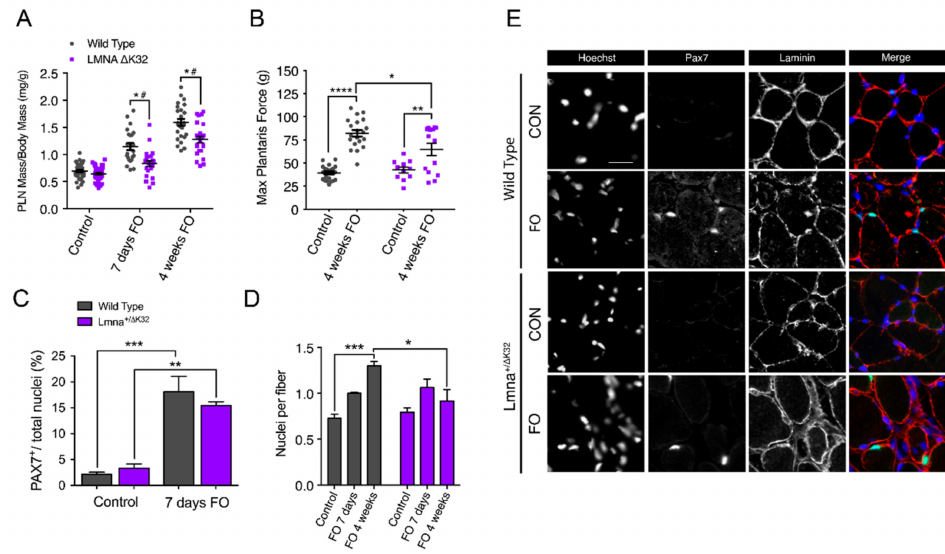
Figure 5. Functional and morphological abnormalities of Lmna+/ ∆ K32 mice to functional overload (FO). ( A ) Plantaris muscle mass normalized by body mass from WT and Lmna+/ ∆ K32 mice in control and after 7-days and 4-weeks FO. * p < 0.05 versus WT, # p < 0.05 versus control conditions. ( B ) Plantaris muscle maximal force from WT and Lmna+/ ∆ K32 mice in control and after 4 weeks FO. * p < 0.05, ** p < 0.005, **** p < 0.0001 ( C ) Quantification of Pax7+ cells as a percentage of total nuclei in control and after 7 days FO. Values are expressed as means ± SEM, ** p < 0.005, *** p < 0.001 versus control condition. ( D ) Quantification of nuclei per fiber from WT and Lmna+/ ∆ K32 mice in control and after 7 days and 4 weeks FO as determined by quantification of Hoechst-stained whole tissue sections by Myovision software. * p < 0.05 and *** p < 0.001. ( E ) Immunofluorescence images of PAX7+ (green) and laminin (red) in plantaris muscle section in WT and Lmna+/ ∆ K32 mice in control and after 7 days FO. Nuclei are stained with Hoechst (blue). Scale bar: 25 µ